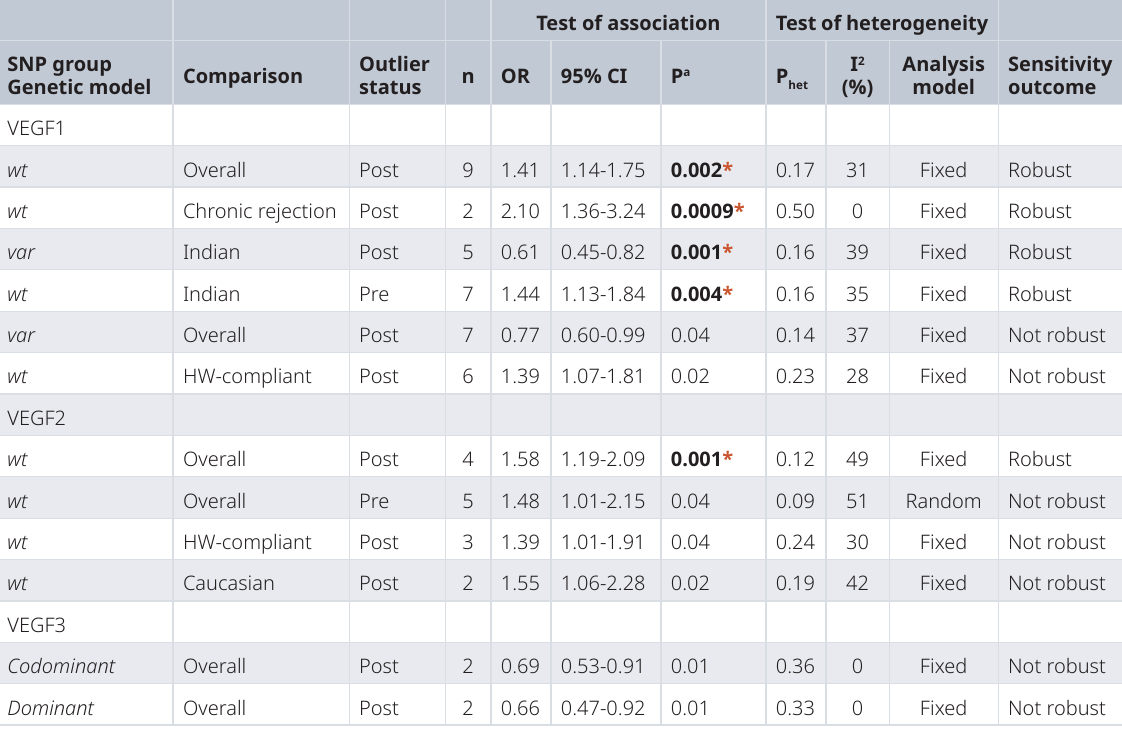
Table 3. Summary of main outcomes of VEGF SNP associations with allograft rejection post-kidney transplantation (chronic +